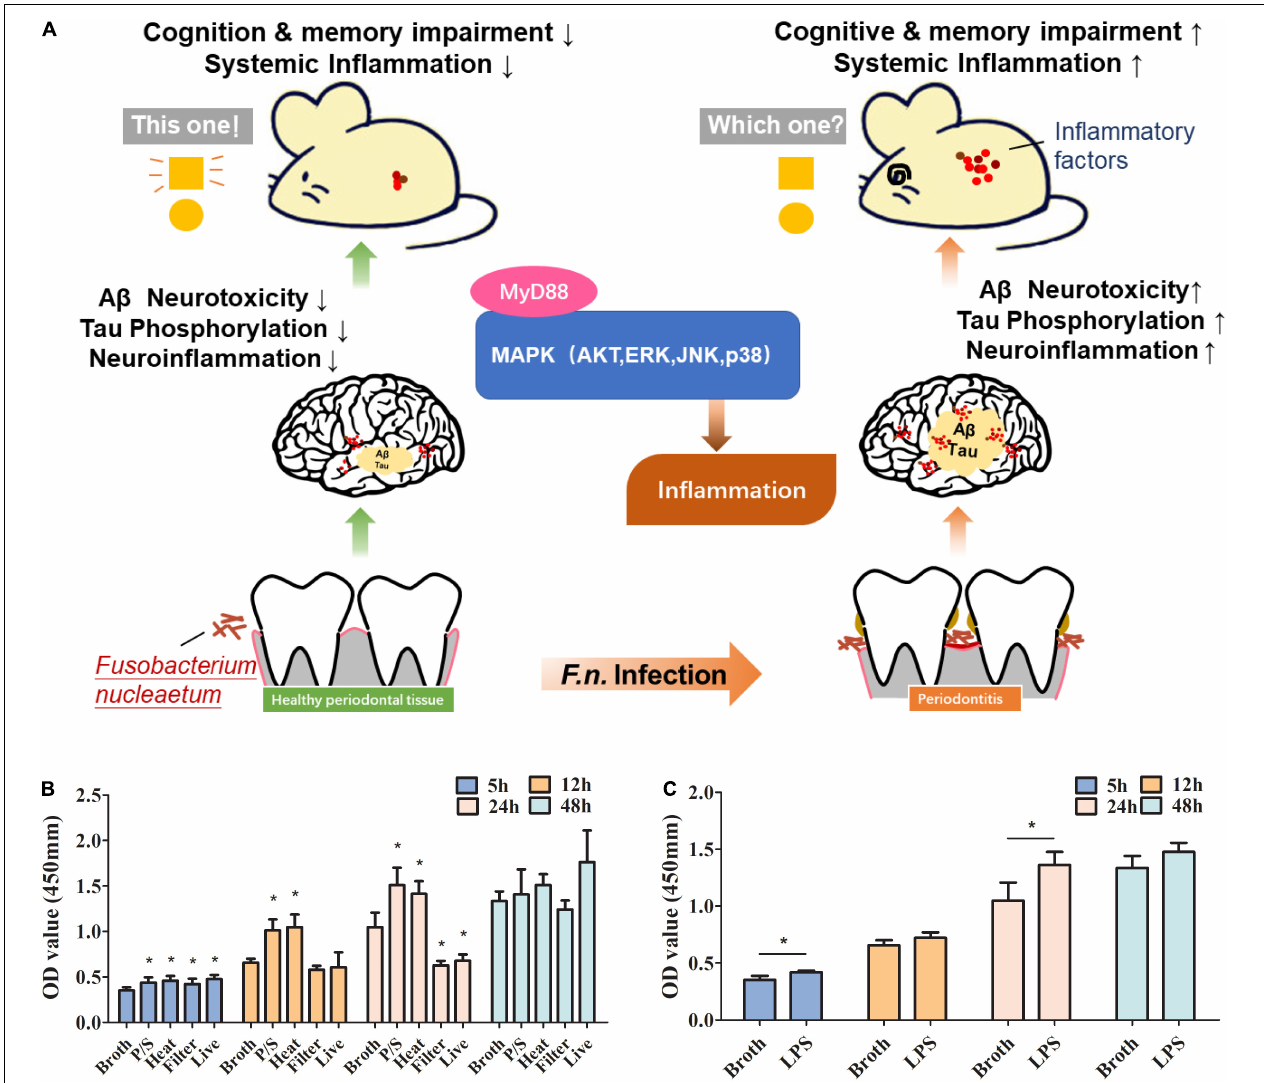
FIGURE 1 | The roles of F. nucleatum in promoting proliferation of microglia in a study using an AD animal model. (A) Schematic diagram of the pathway that F. nucleatum exacerbates Alzheimer’s pathogenesis. (B) Evaluation of the effect of F. nucleatum has on the proliferation of SIM-A9 cells by CCK8 assay. Bacterial solution treated with the antibiotic, heating, or filtration, along with sterile bacteria broth and untreated bacterial solution were co-cultured with SIM-A9 for 5, 12, 24, and 48 h. (C) Evaluation of the effect of LPS of F. nucleatum on the proliferation of SIM-A9 cells by CCK8 assay. All data were expressed as mean ± SD. *P < 0.05 vs. Broth